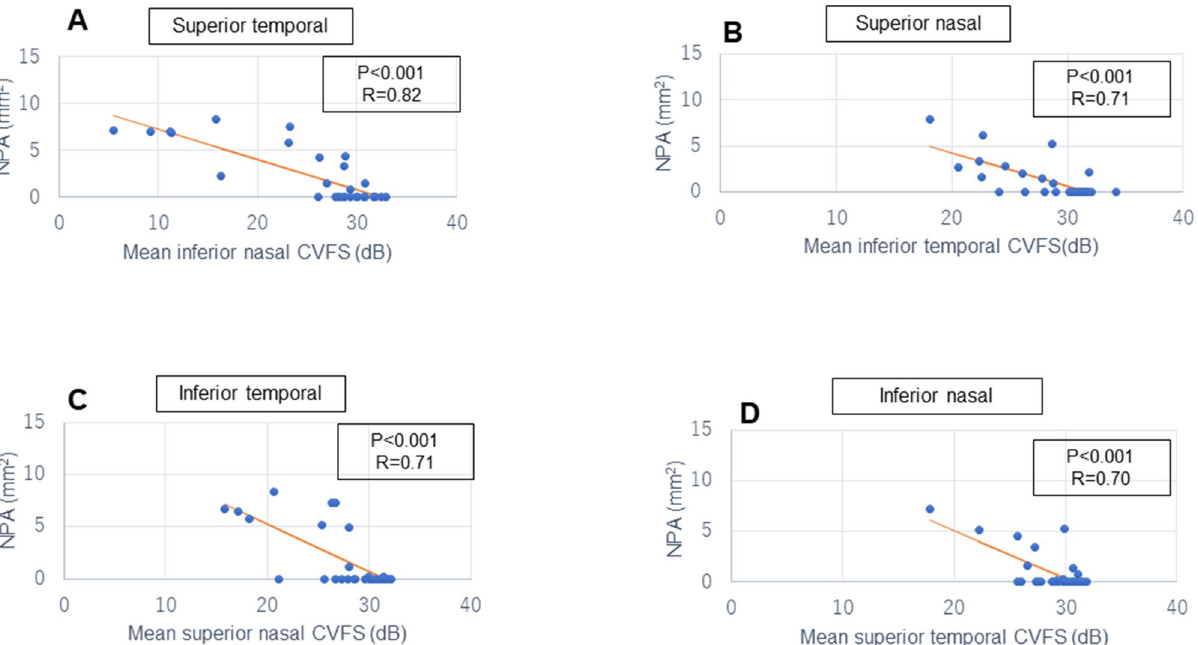
Figure 2. Scatter plots of the correlation between macular m-NPA on OCT angiography in the DCP and corresponding CVFS values on HFA 10-2. ( A ) m-NPA in the superior temporal region and mean inferior nasal CVFS ( B ) m-NPA in the superior nasal region and mean inferior temporal CVFS ( C ) m-NPA in the inferior temporal region and mean superior nasal CVFS ( D ) m-NPA in the inferior nasal region and mean superior temporal CVFS. m-NPA macular non-perfused areas, OCT optical coherence tomography, DCP deep capillary plexus, HFA10-2 Humphrey visual field analyser 10-2 programme, CVFS central visual field